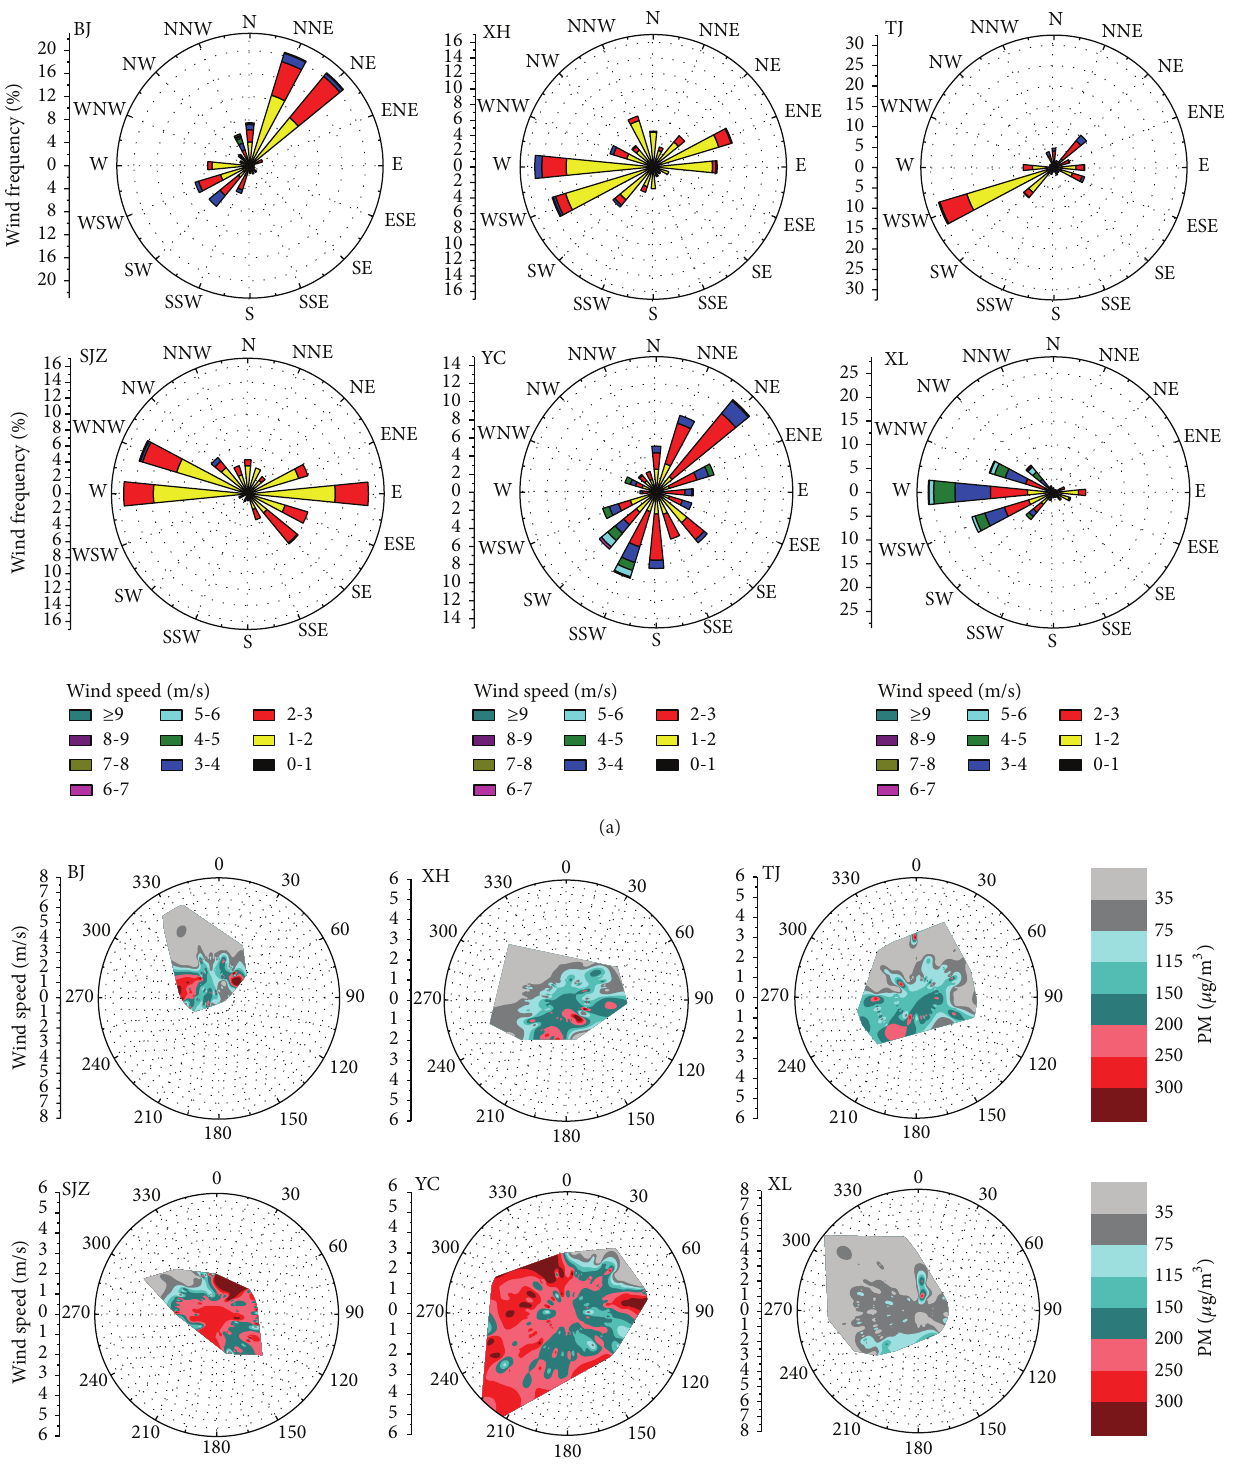
Figure 8: Maps of (a) wind roses and (b) relationships between hourly average PM 2.5 concentration and wind